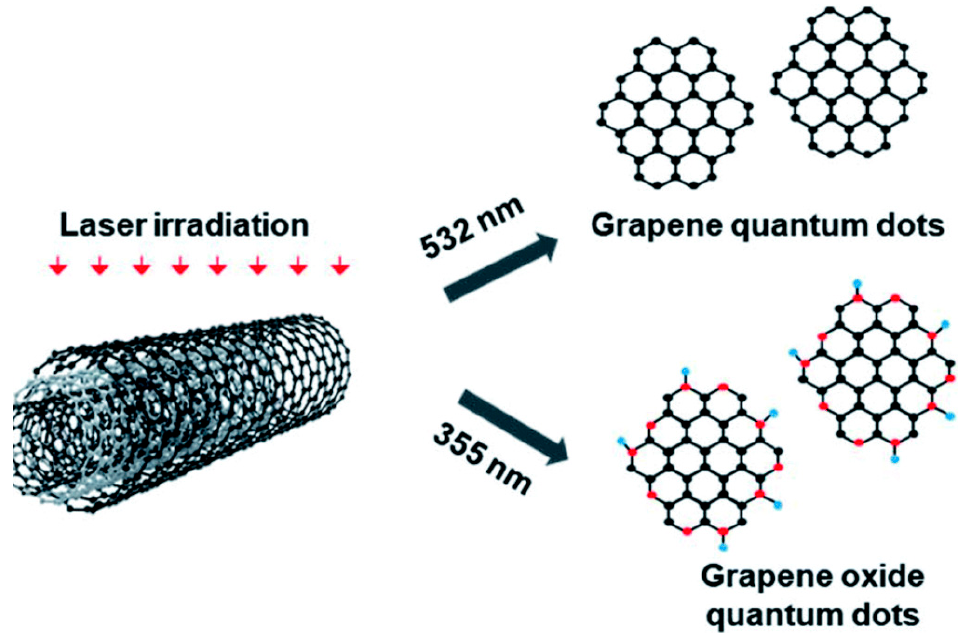
Figure 5. A schematic illustration for the generation of GQDs from PLAL process. Reprinted with permission from Ref. [50].